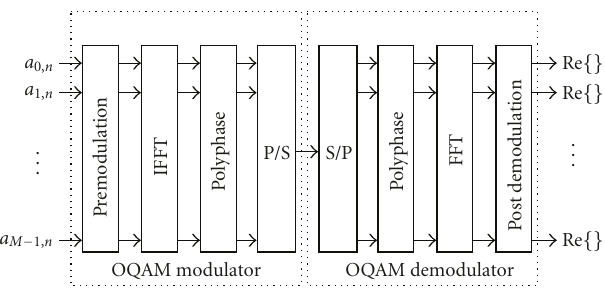
Figure 1: Transmultiplexer scheme for the OFDM/OQAM modulation.